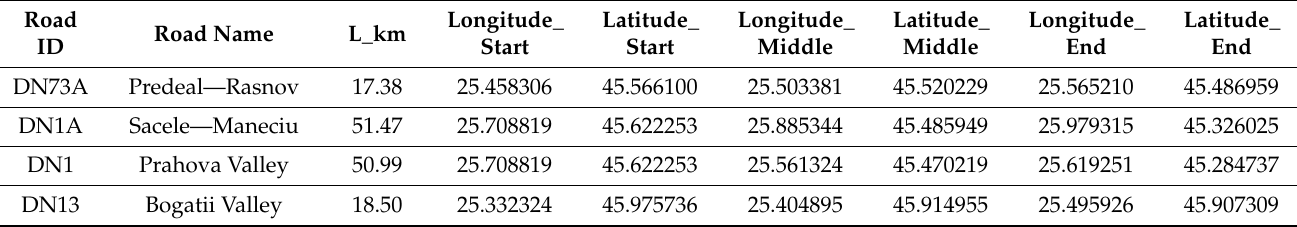
Table 1. Geographic coordinates for the analyzed